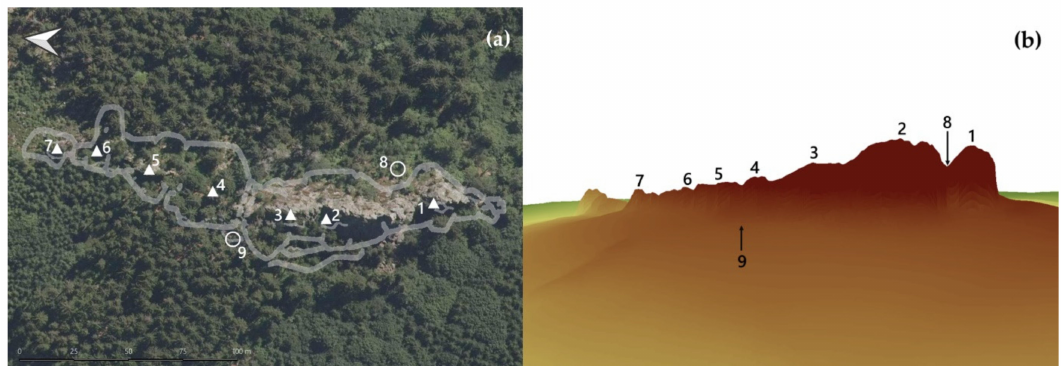
Figure 2. ( a ) Specific outcrops of Dr á tenick á sk á la on the orthophoto image [56]). ( b ) Digital terrain model of Dr á tenick á sk á la rock formation from the south [57,58]. Names of particular outcrops and other formations: 1—Orl í vˇež (Eagle’s tower), 2—Otoman, 3—Sokol (Falcon), 4—Zbojnick á vˇež (Brigand´s tower), 5—Indi á nsk á vˇež (American Indian´s tower), 6—Opiˇc í vˇežka (Monkey´s pinnacle), 7—Kos á vˇežka (slant pinnacle), 8—Krakonošova zahr á dka (Krakonoš garden), and